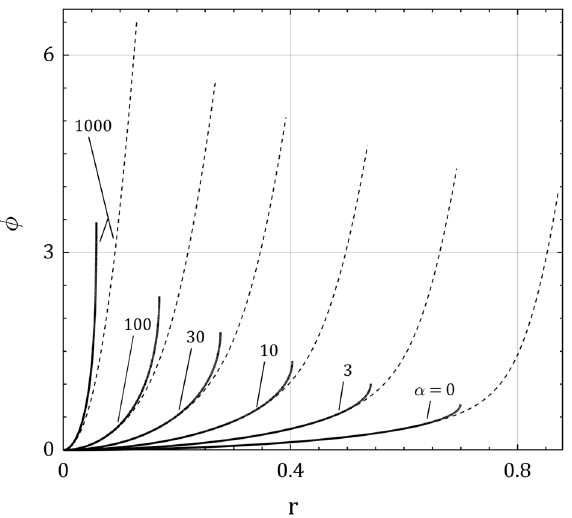
0.5 in the plasma space r . The curves illustrate = 0 ) and the full solution (dashed curves for ǫ =